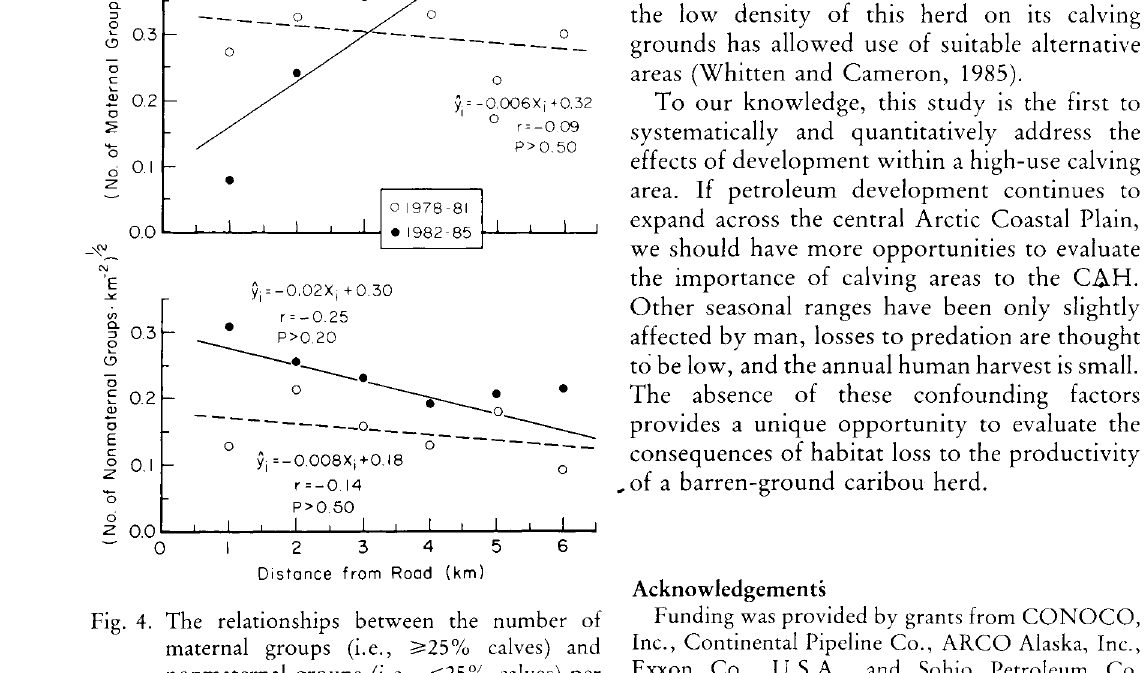
Fig. 4. The relationships between the number of maternal groups (i.e., ^25% calves) and nonmaternal groups (i.e., <25% calves) per km 2 , and distance from roads during June 1978 - 81 and 1982 - 85, Milne Point, Alaska. Data points shown are strata means for each 4-year period; however, linear models were fit using data for individual